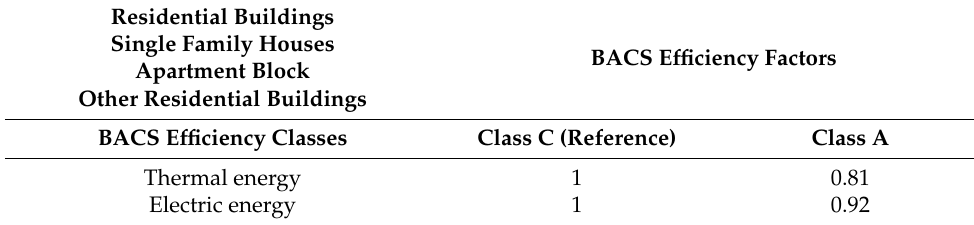
Table 5. The overall BACS efficiency factors for residential